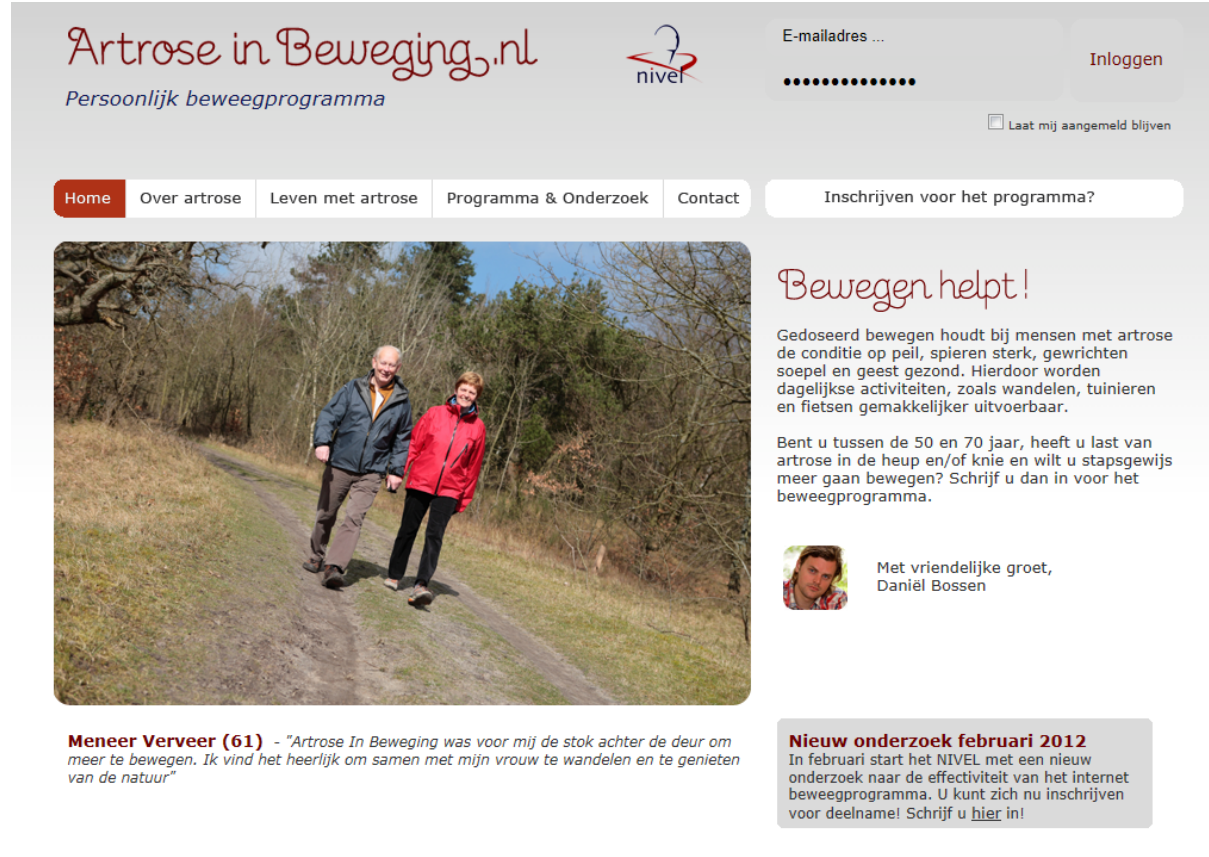
Figure 1. Homepage